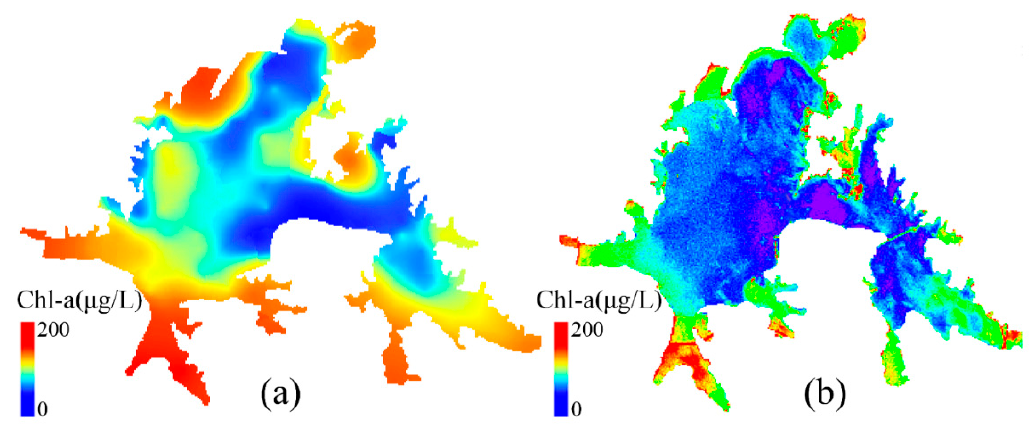
Figure 5. Comparison of the observed ( a ) and Landsat-predicted ( b ) Chl-a concentration distribution map on 18 April 2016.